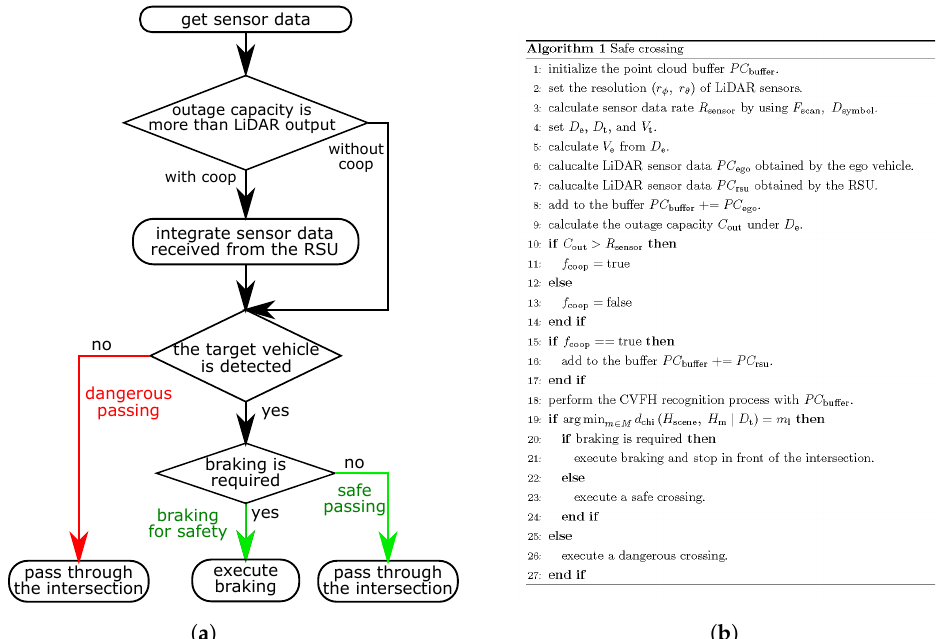
Figure 10. Description of the whole process in the simulation: ( a ) Block diagram of a safe crossing. ( b ) Algorithm of a safe crossing.